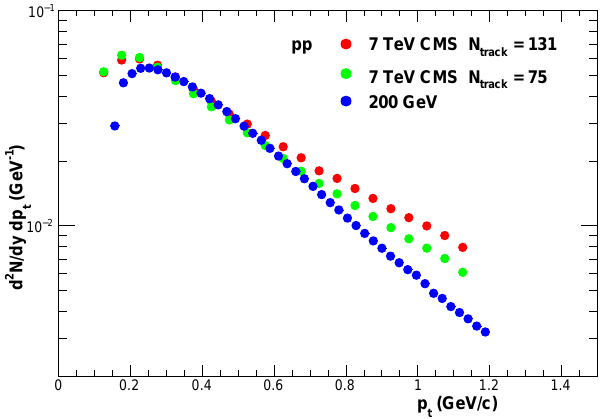
√ s = 7 TeV for two different Figure 4. Transverse momentum spectra of pions from CMS experiment at multiplicity cuts N track = 131 (red solid circle) and N track = 75 (green solid circle) [17]. For comparison √ s = 200 GeV is also shown (solid blue circle) purpose the p t spectra from pp at